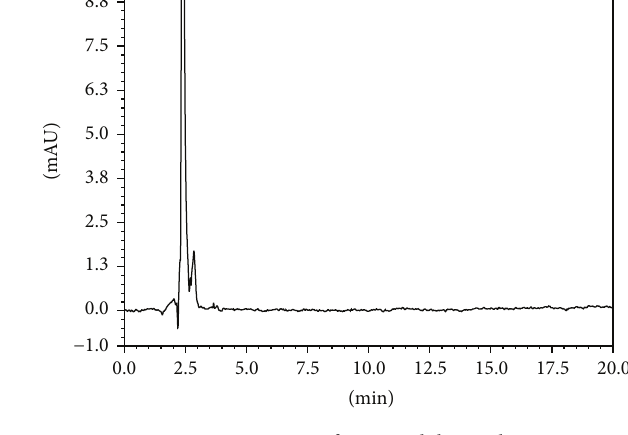
Figure 2: Blank for swabs (diluent).